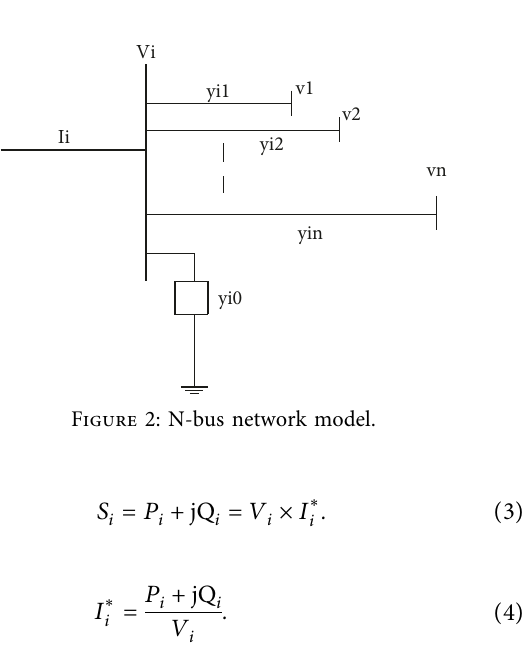
Figure 2: N-bus network model.